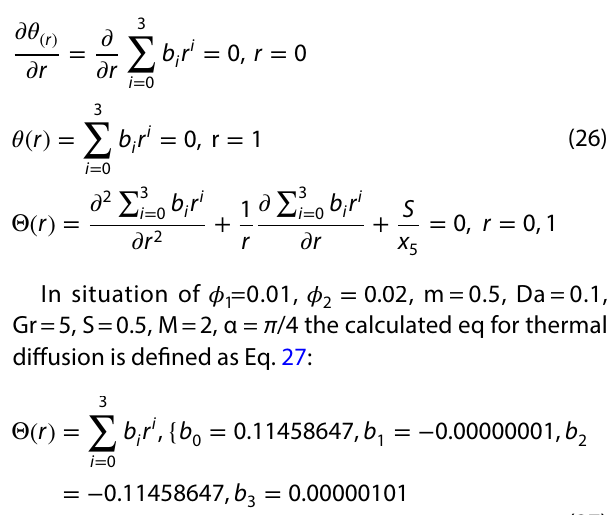
Fig. 3 Differences between the Runge–Kutta method with the result of S. DAS, ref